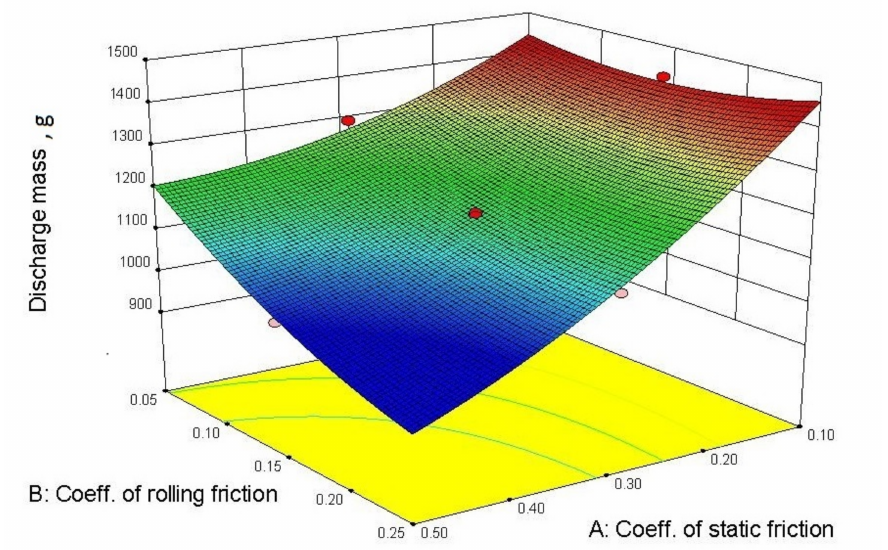
Figure 12. Response surface of the discharge mass versus the AB interaction.